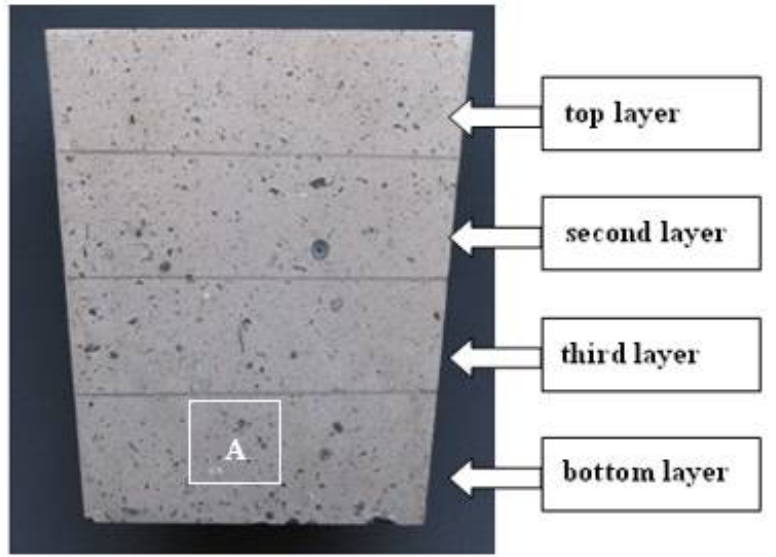
Figure 2. Zones of the inclusions distribution in the longitudinal section of ingot.